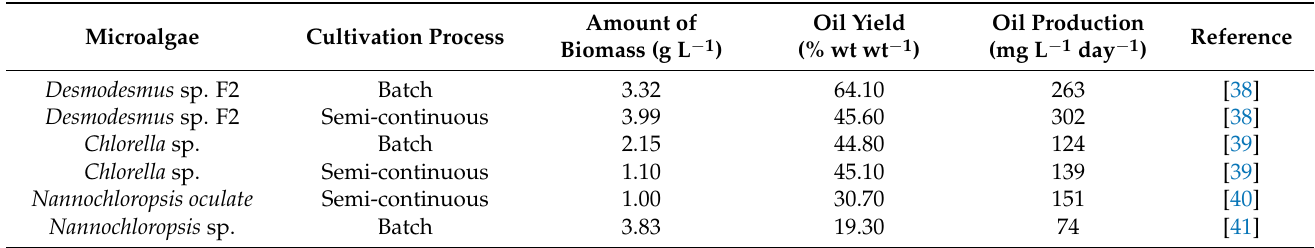
Table 3. Comparison of cultivation process for microalgae oil production of some selected species of microalgae reported in